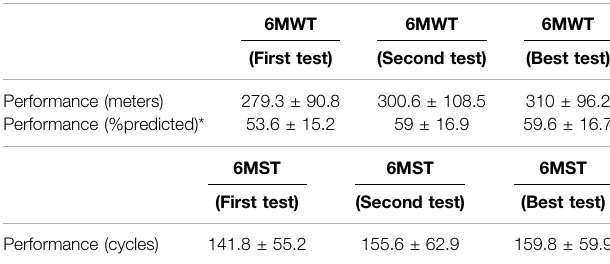
TABLE 1 | Characterization of the study participants ( n = 16). TABLE 2 | Performance average in fi rst, second, and the best 6MWT and